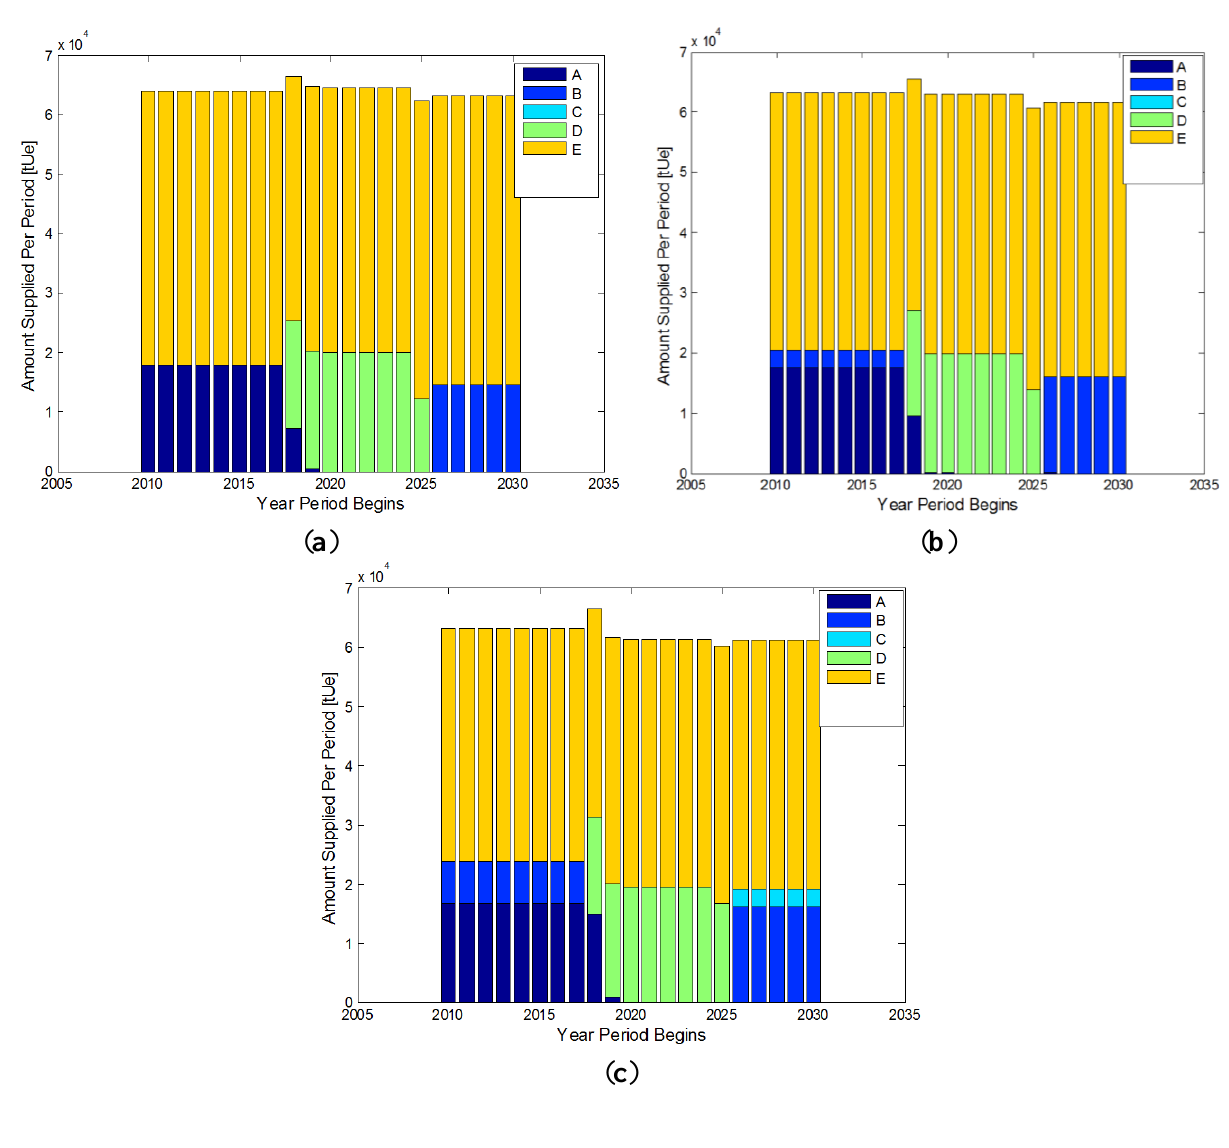
Figure 6. Amount supplied per period with coefficients: ( a ) Q = 0.5, P = 0.5; ( b ) Q = 0.7, P = 0.5; ( c ) Q = 0.8, P =